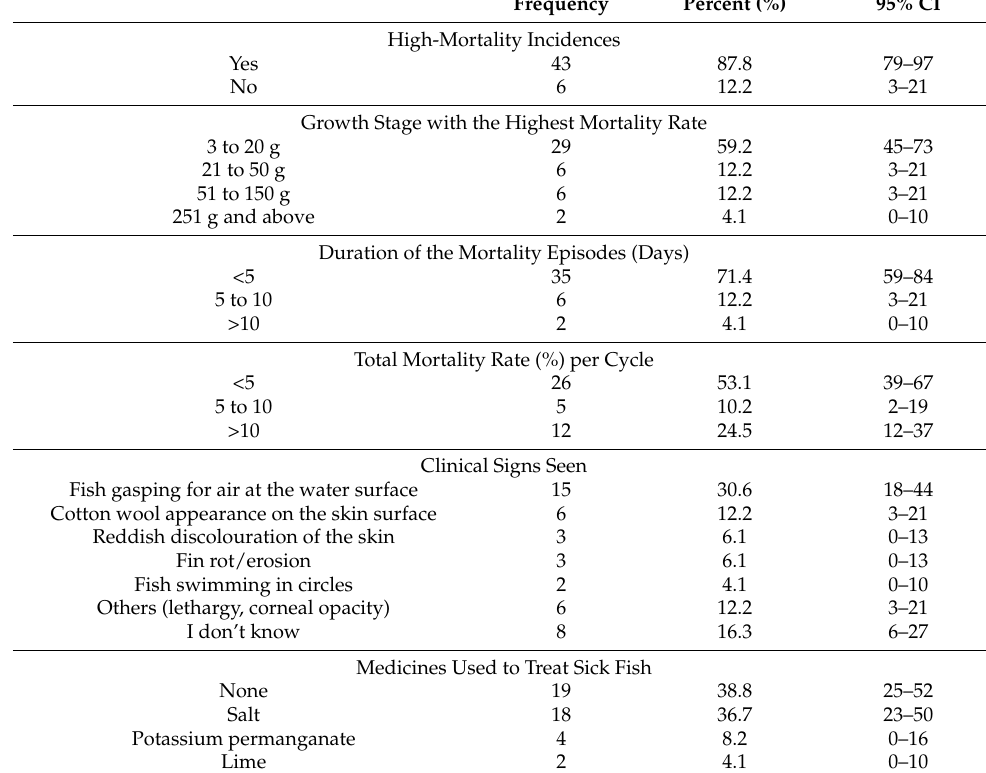
Table 3. Clinical signs and disease outbreak trends as per farmer